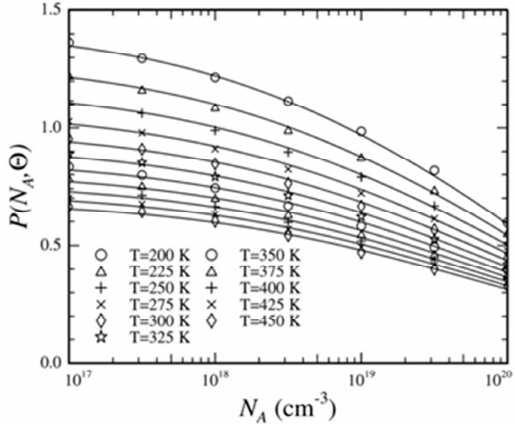
Figure 6. Fitted piezoresistive factor for π 44 as a function of doping concentration and temperature; Reprinted from [51], with permission of AIP Publishing.